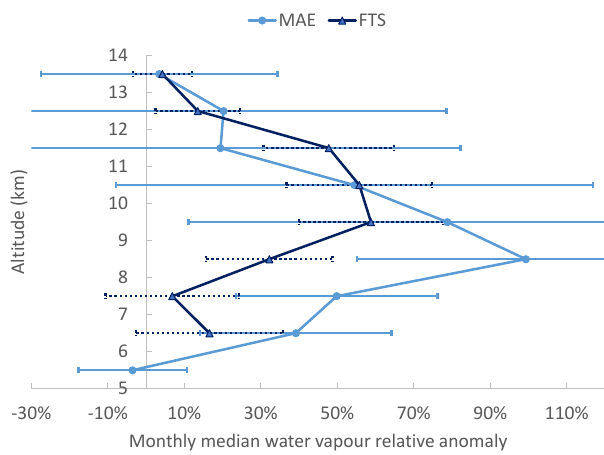
Figure 9. Water vapour relative anomaly in May 2010 at north- ern high latitudes following the Eyjafjallajökull eruption. The un- certainty accounts for the interannual standard deviation for May (2005–2012) and the relative standard error of individual profiles from the month of May 2010, combined in quadrature ( N = 132, 178 for MAESTRO and ACE-FTS,